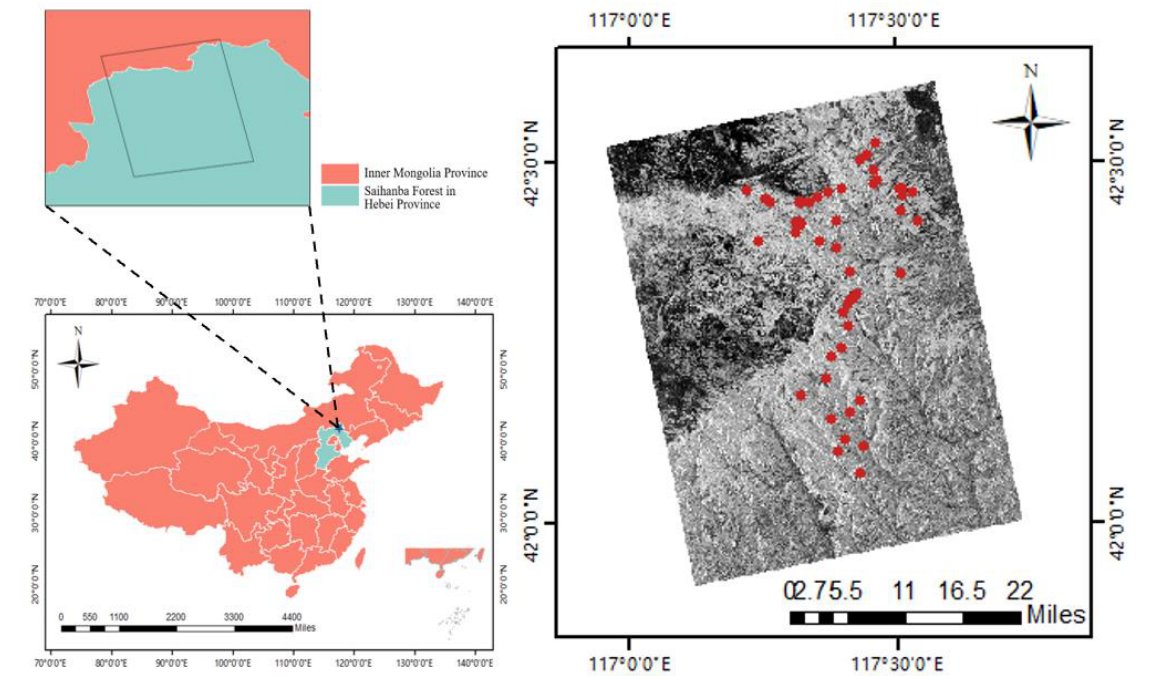
Figure 1. The map of the study area. The area is located in the Saihanba Forest, China. The distribution of the real sample locations is indicated by the red dots. The image of the study area is derived from SAR data under HV polarization.